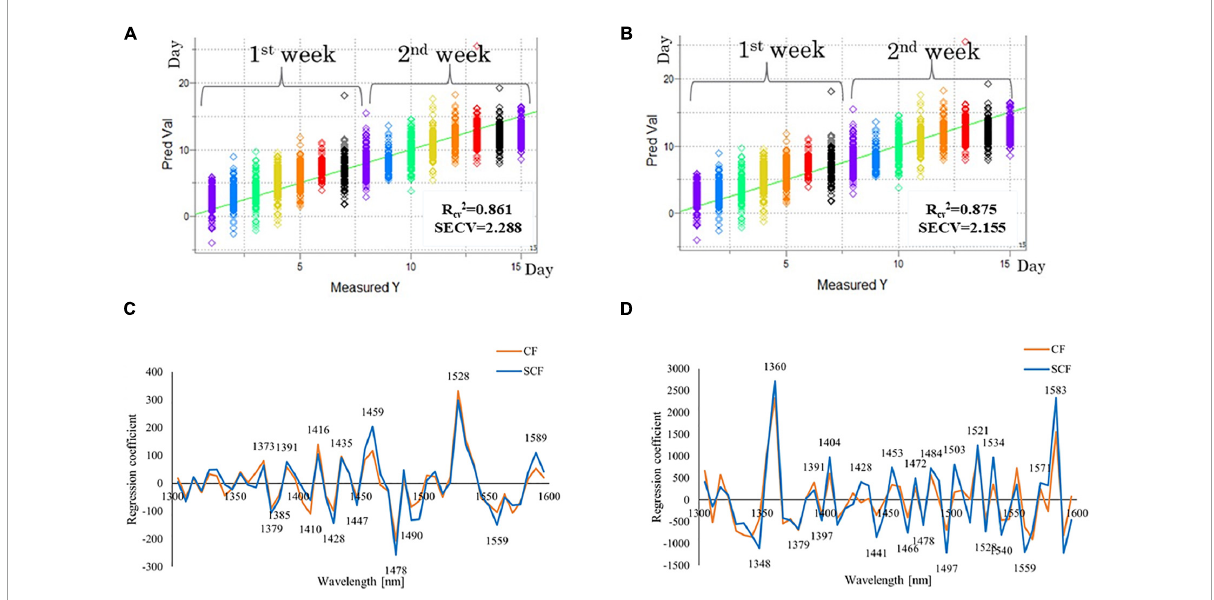
FIGURE6 Results of partial least squares (PLS) regression modeling using time as a dependent variable (days of storage). (A) Y-fit plot, showing agreement between actual number of storage days and predicted number of storage days using PLS time regression model for spectra of strawberries in the control fridge (CF) condition (B) Y-fit plot, showing agreement between actual number of storage days and predicted number of storage days using PLS time regression model for spectra of strawberries in the supercooling fridge (SCF) condition (C) regression vectors of PLSR models built using spectral data of strawberry stored in CF and SCF conditions - comparison between regression vectors of models for the first 4 days of storage; (D) regression vectors of PLSR models built using spectral data of strawberry stored in CF and SCF conditions - comparison between regression vectors of models for the 15 days of